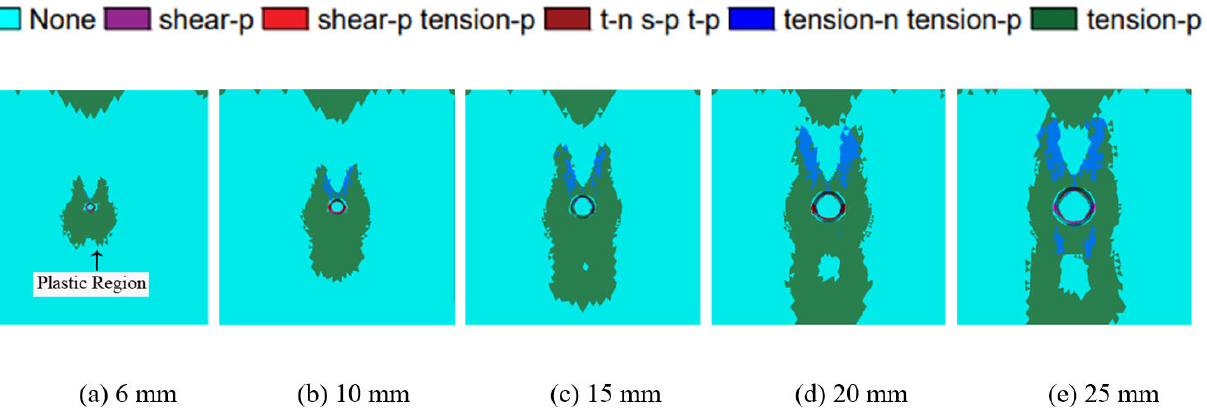
Figure 6. Plastic zone diagram of different borehole diameters.